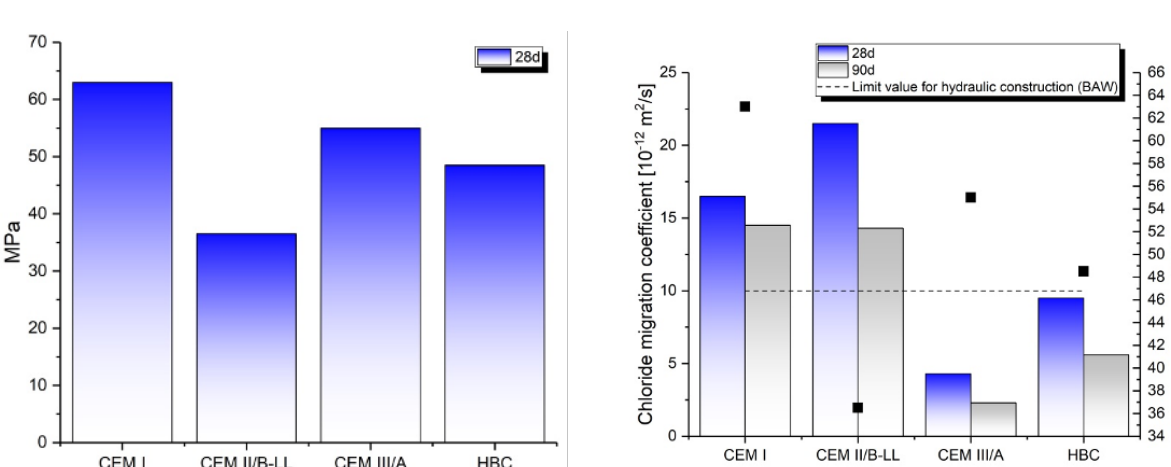
Figure 1. Comparison of the mortar compressive strength development correlated with the heat of hydration referred to the mass of cement.